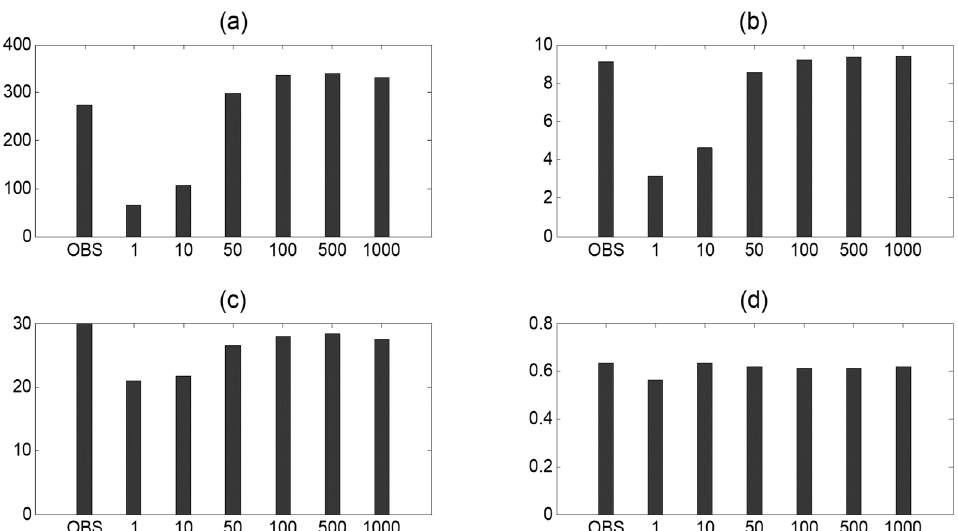
Figure 3. Determination of the number of random resampling. As the number of resampling increases, each index value gradually converges with the observed results and gradually stabilizes (repeat sampling has stabilized after 1000 times). The results of different indicators were gradually stabilized: ( a ) Prtot (mm/season); ( b ) SDII (mm/day); ( c ) nr001 (days); ( d ) P95T (%).